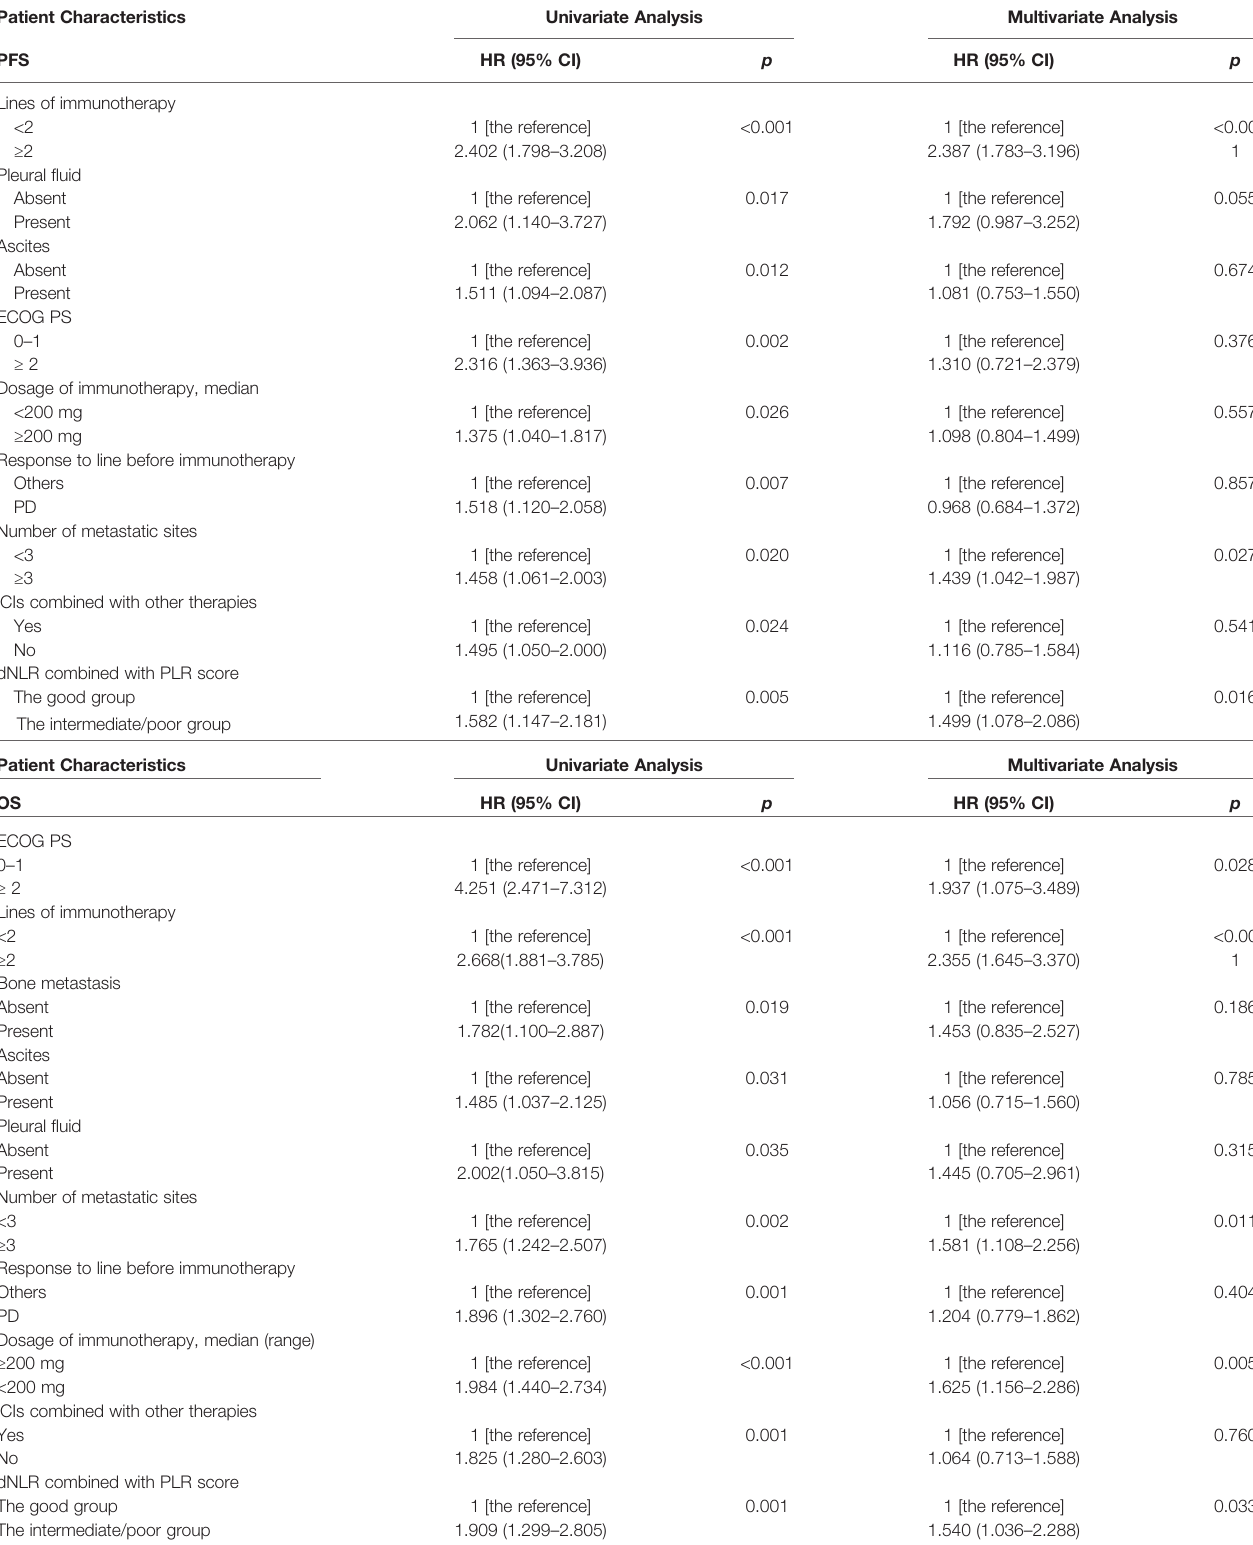
TABLE 5 | Univariate and multivariate analyses of factors associated with PFS and